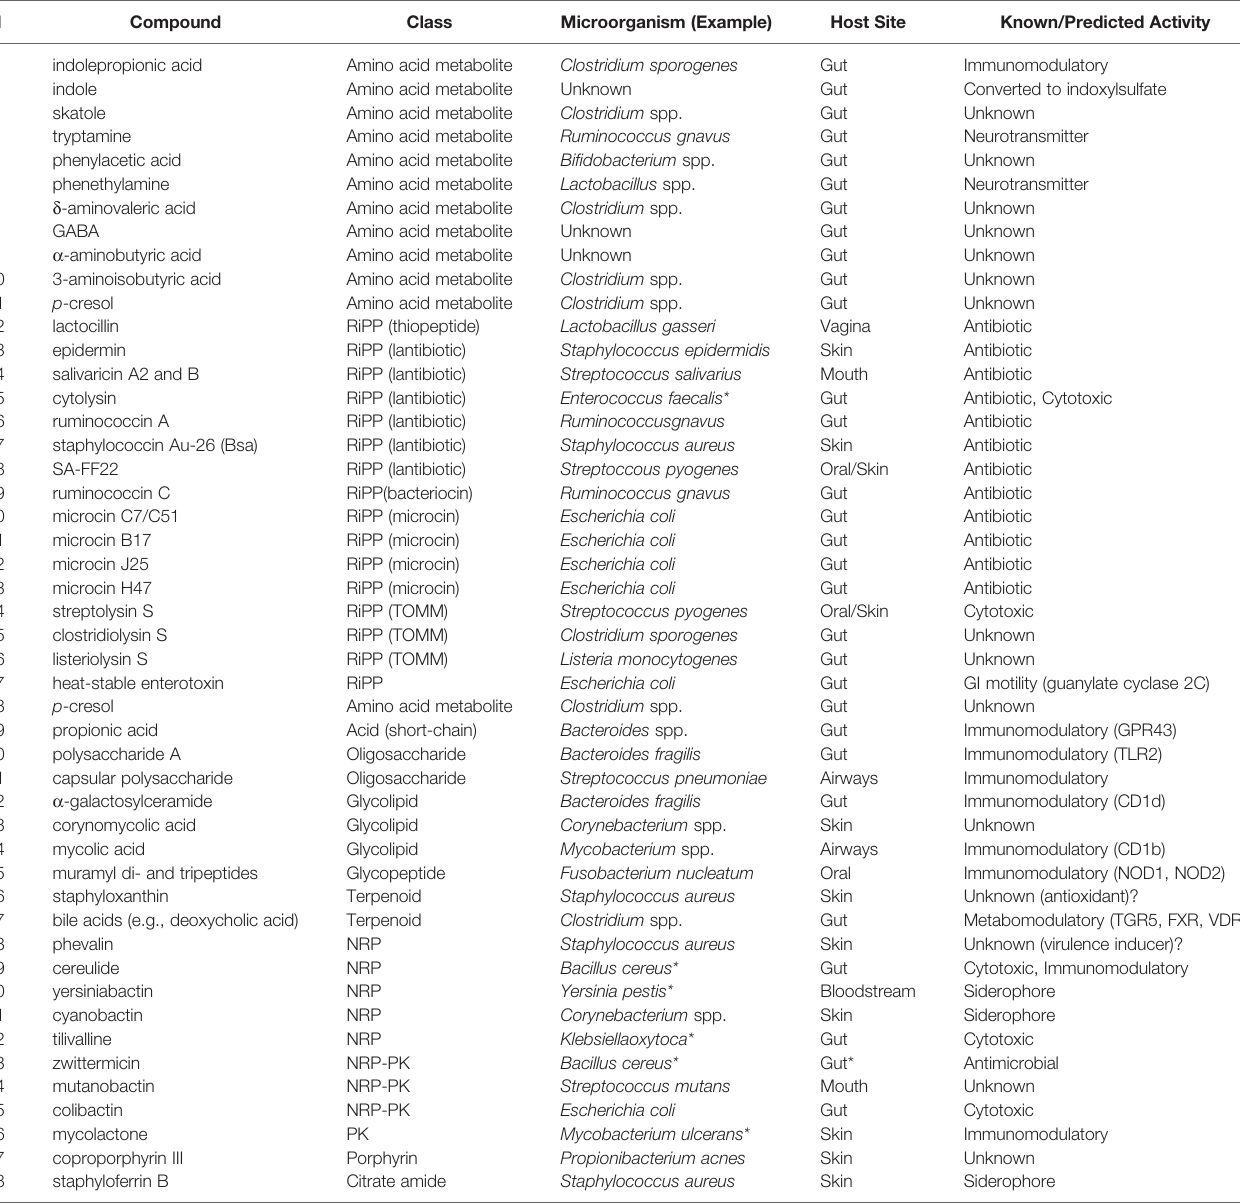
TABLE 1 | Selected small molecules from the human gut microbiota with name, class, origin, and activities within human body (Donia and Fischbach, 2015). SI